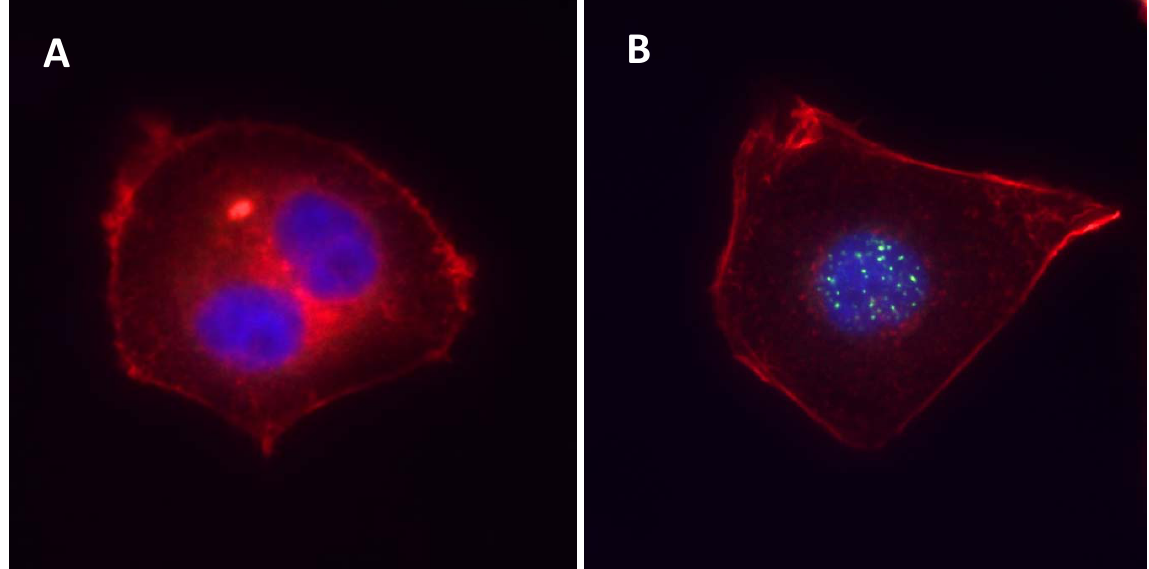
Figure 1. H2AX phosphorylation in undifferentiated nasopharyngeal carcinoma cell HONE1. ( A ) a dividing cell with intact nuclei without exposing to ionizing radiation; ( B ) HONE1 cell after exposing to 8 Gy ionizing radiation. The cells were fixed 24 hours S139) antibody (abcam). FITC Goat Anti-Rabbit IgG Conjugage (Invitrogen) was used to DAPI (Invitrogen); F-actin was labeled in red with Alexa Fluor ® 635 phalloidin